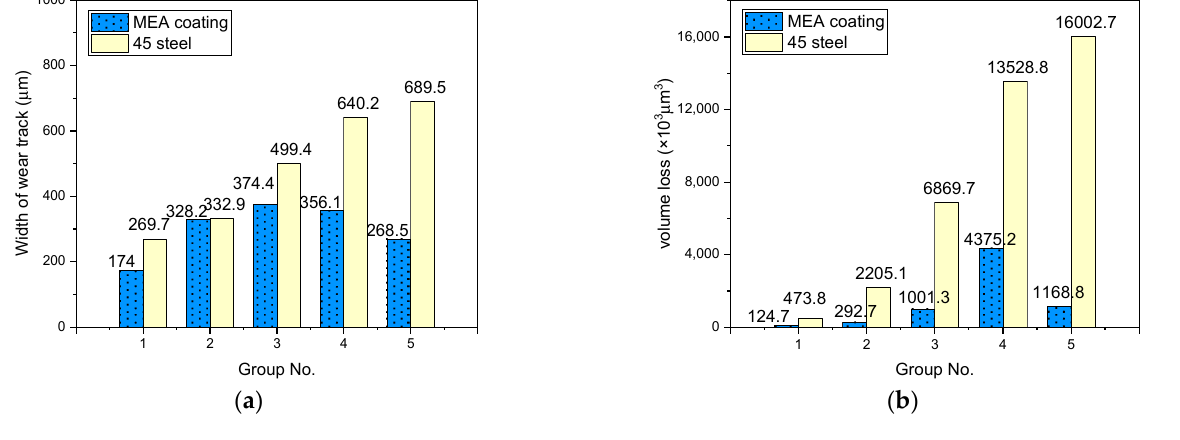
Figure 9. Average width of wear track ( a ), volume loss ( b ). Table 3. Wear rates of the MEA coating and 45 steel at different loads and temperatures. Group